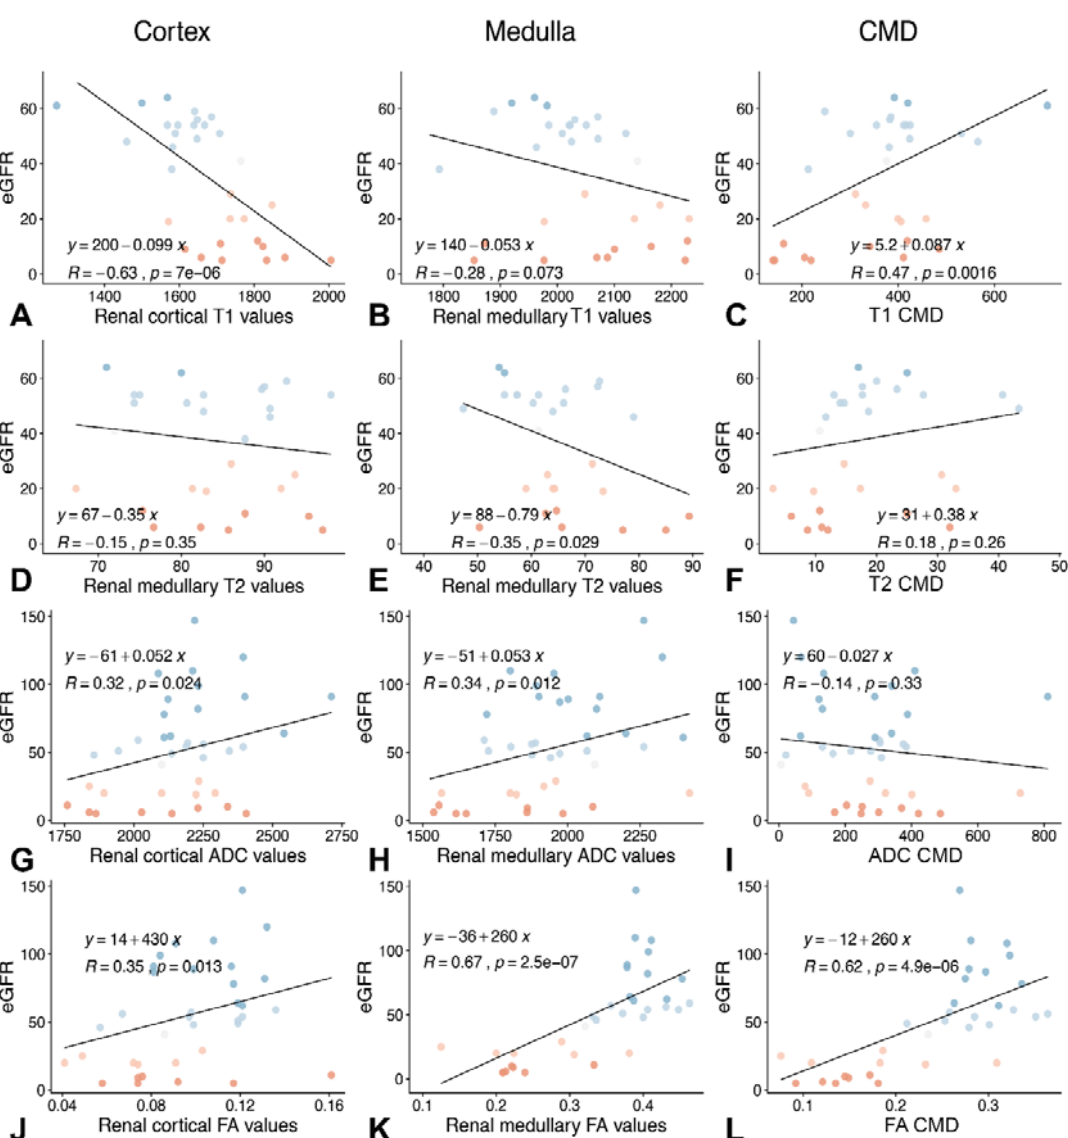
Figure 3. Correlation of cortical (left column), medullary (middle column) and corticomedullary di ff erentiation parameters (right column) with e GFR. The first row ( A – C ) shows the correlation between T1 parameters (cortical T1 values ( A ); medullary T1 values ( B ); and T1 corticomedullary di ff erentiation (CMD) ( C )) and e GFR. The second row ( D – F ) shows the correlation between T2 parameters (cortical T2 values ( D ); medullary T2 values ( E ); and T2 CMD ( F )) and e GFR. The third row ( G – I ) shows the correlation between ADC parameters (cortical mean ADC values ( G ); medullary mean ADC values ( H ); and ADC CMD ( I )) and eGFR. The fourth row ( J – L ) shows the correlation between FA parameters (cortical mean FA values ( J ); medullary mean FA values ( K ); and FA CMD ( L )) and e GFR. The best correlations with e GFR could be obtained for renal cortical T1 values ( r = − 0.63, A ), for mean medullary FA values and e GRF ( r = 0.67 ( K )) and for FA CMD ( r = 0.62 ( L )). In comparison to T1 and FA values, T2 and medullary ADC values showed significant, but low to negligible correlations ( r between 0.14 and 0.35). Blue colors of the points indicate higher e GFR.